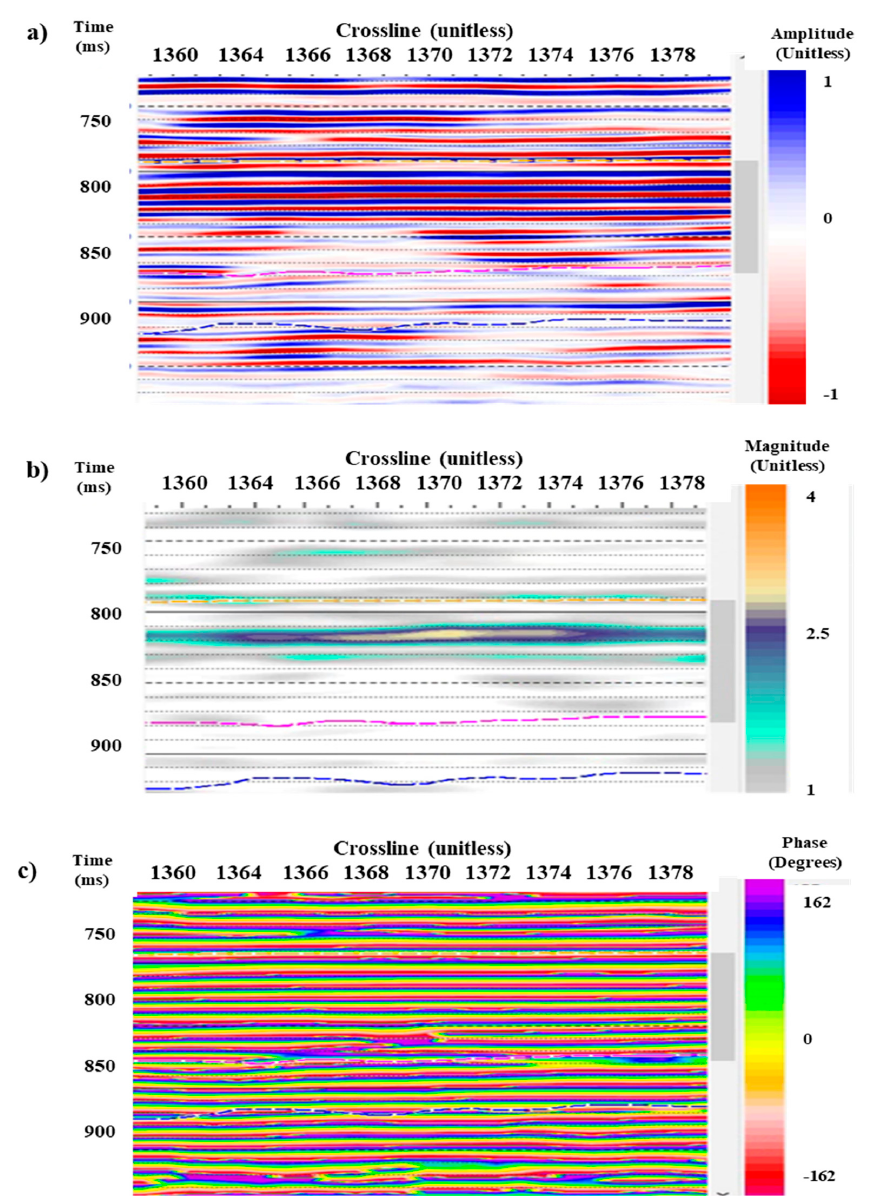
Figure 5. ( a ) Amplitude at 100 Hz (polarity: an increase in amplitude corresponds to an increase in acoustic impedance), ( b ) magnitude at 100 Hz, and ( c ) phase at 100 Hz. Group 4 includes all attributes in Groups 1 to